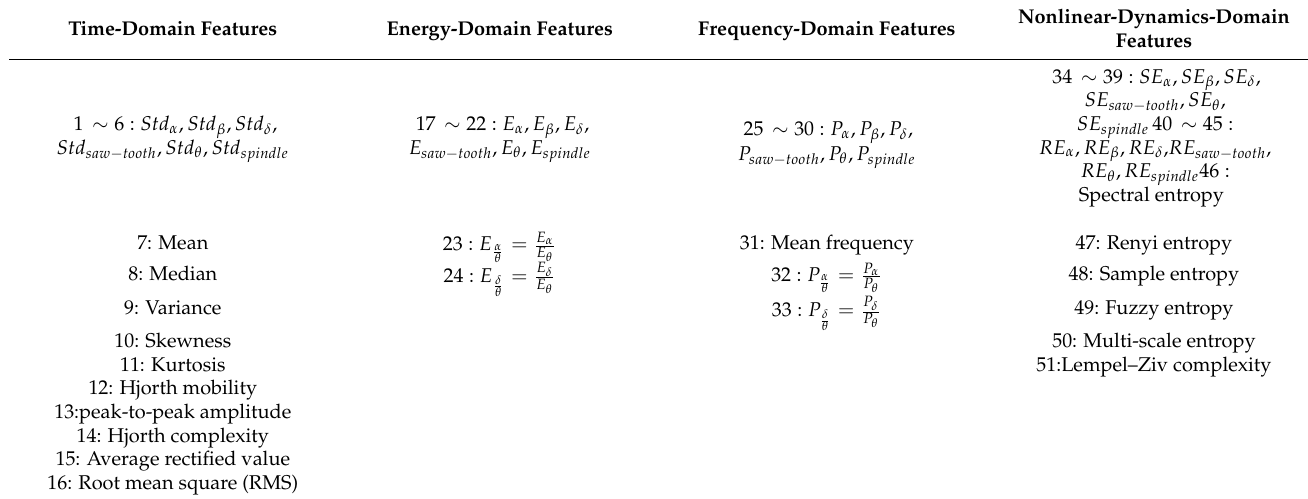
Table A2. Different features considered in this study.